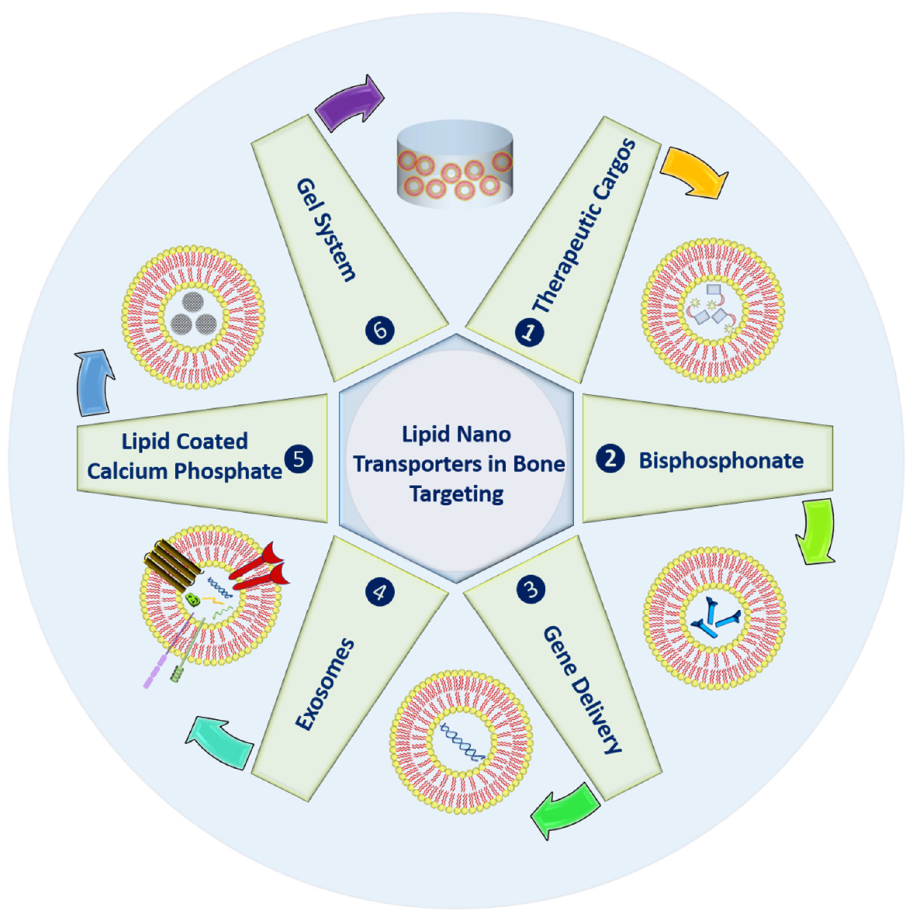
Figure 1. Types of the lipid nano-transporters in bone targeting.